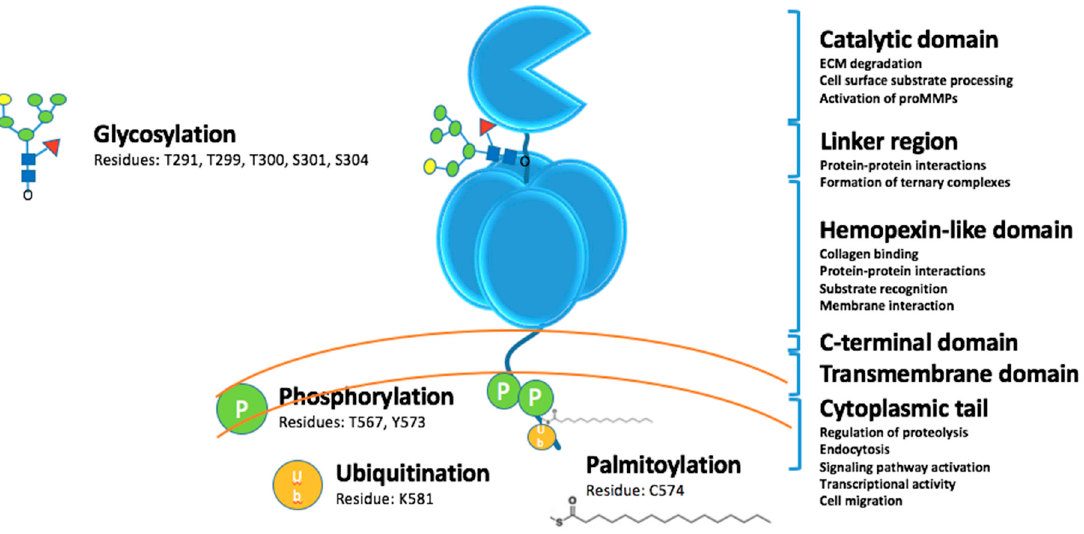
Figure 1. MT1-MMP domains and posttranslational modifications.